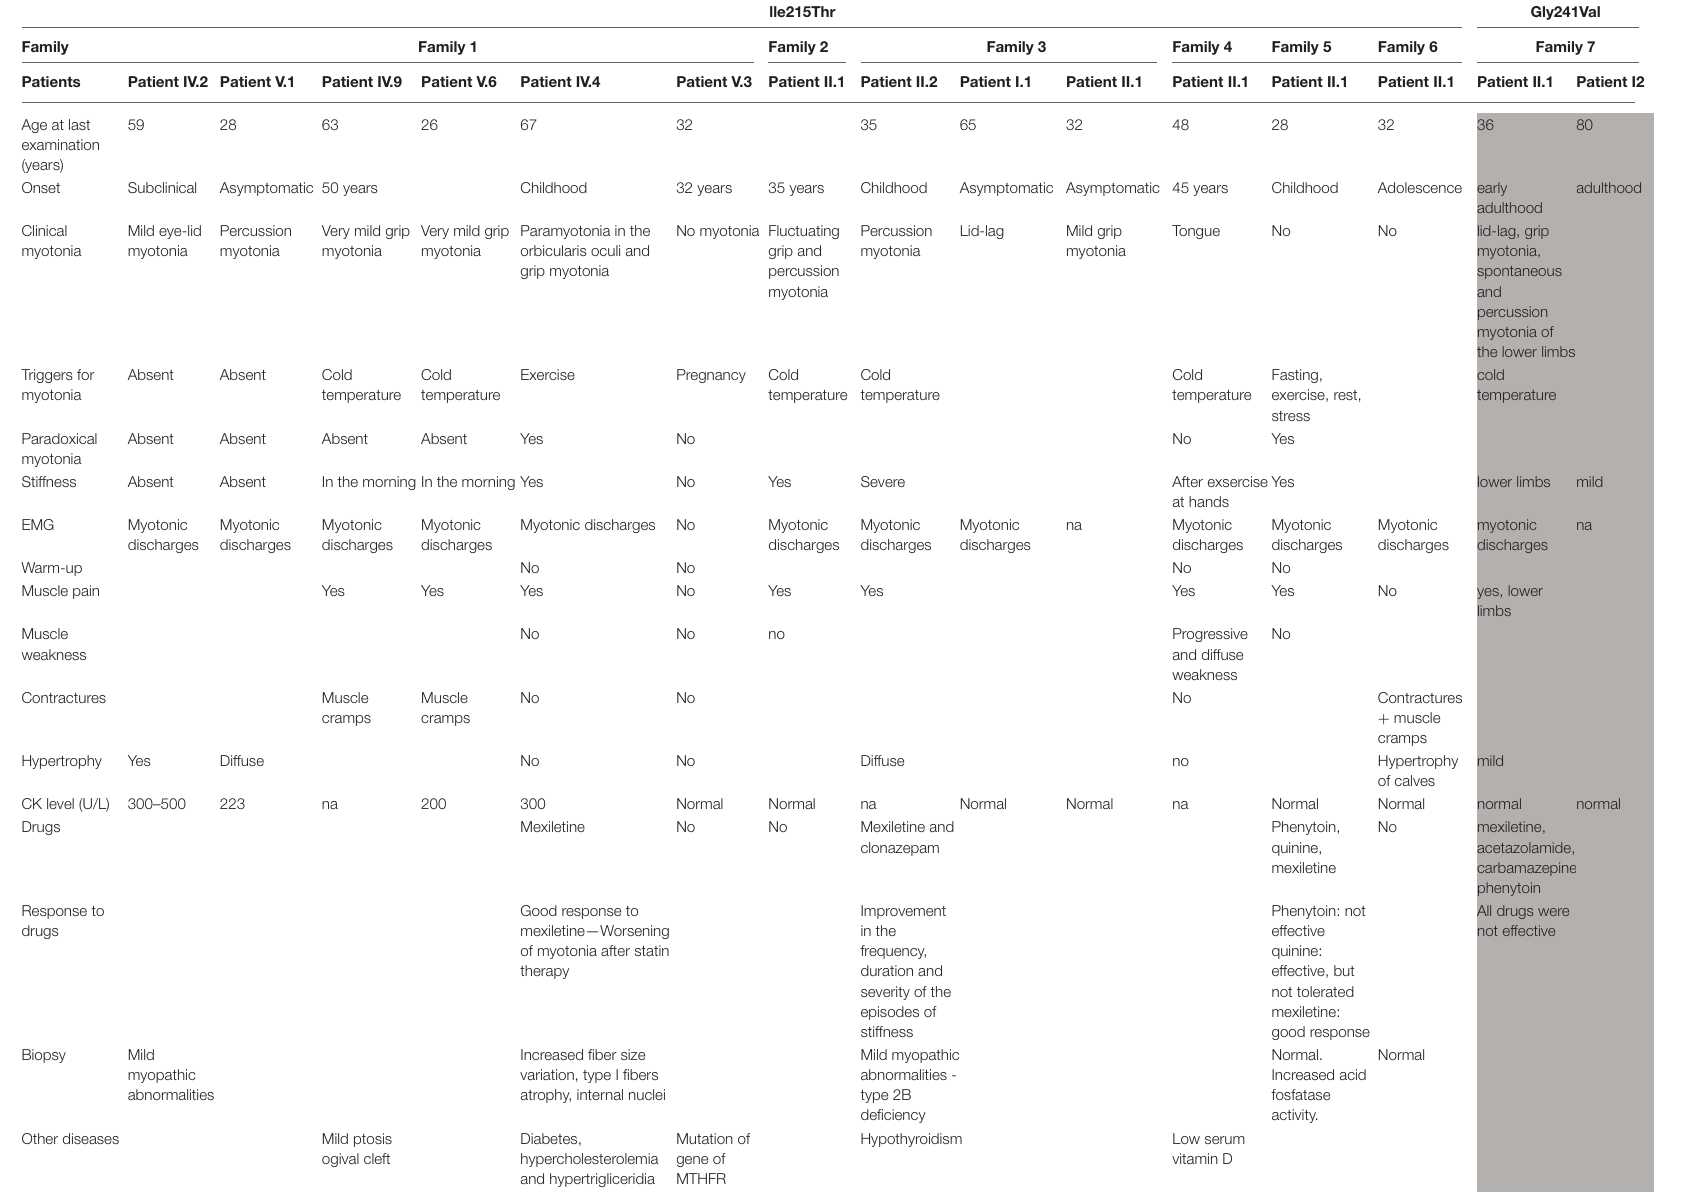
TABLE 1 | Clinical signs and instrumental